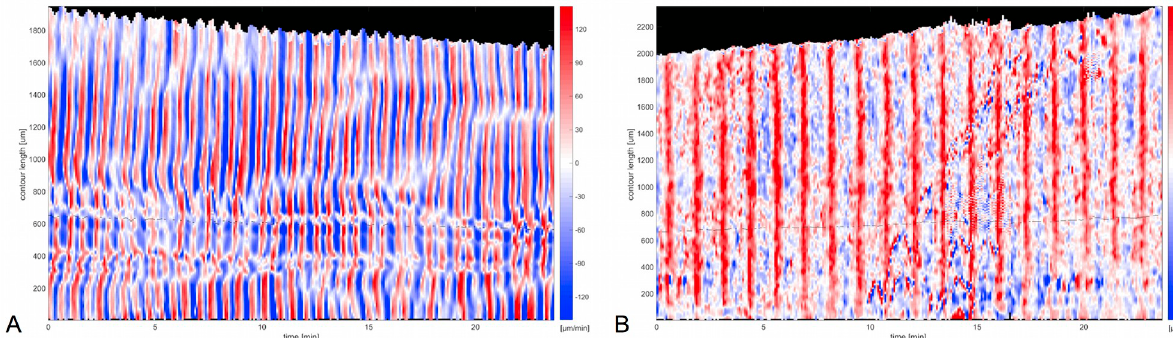
Fig 5. Frequency selection. A) Velocity chart of uroid of mesoplasmodium. B) Velocity chart of front. Data was obtained as given in section Contour detection.